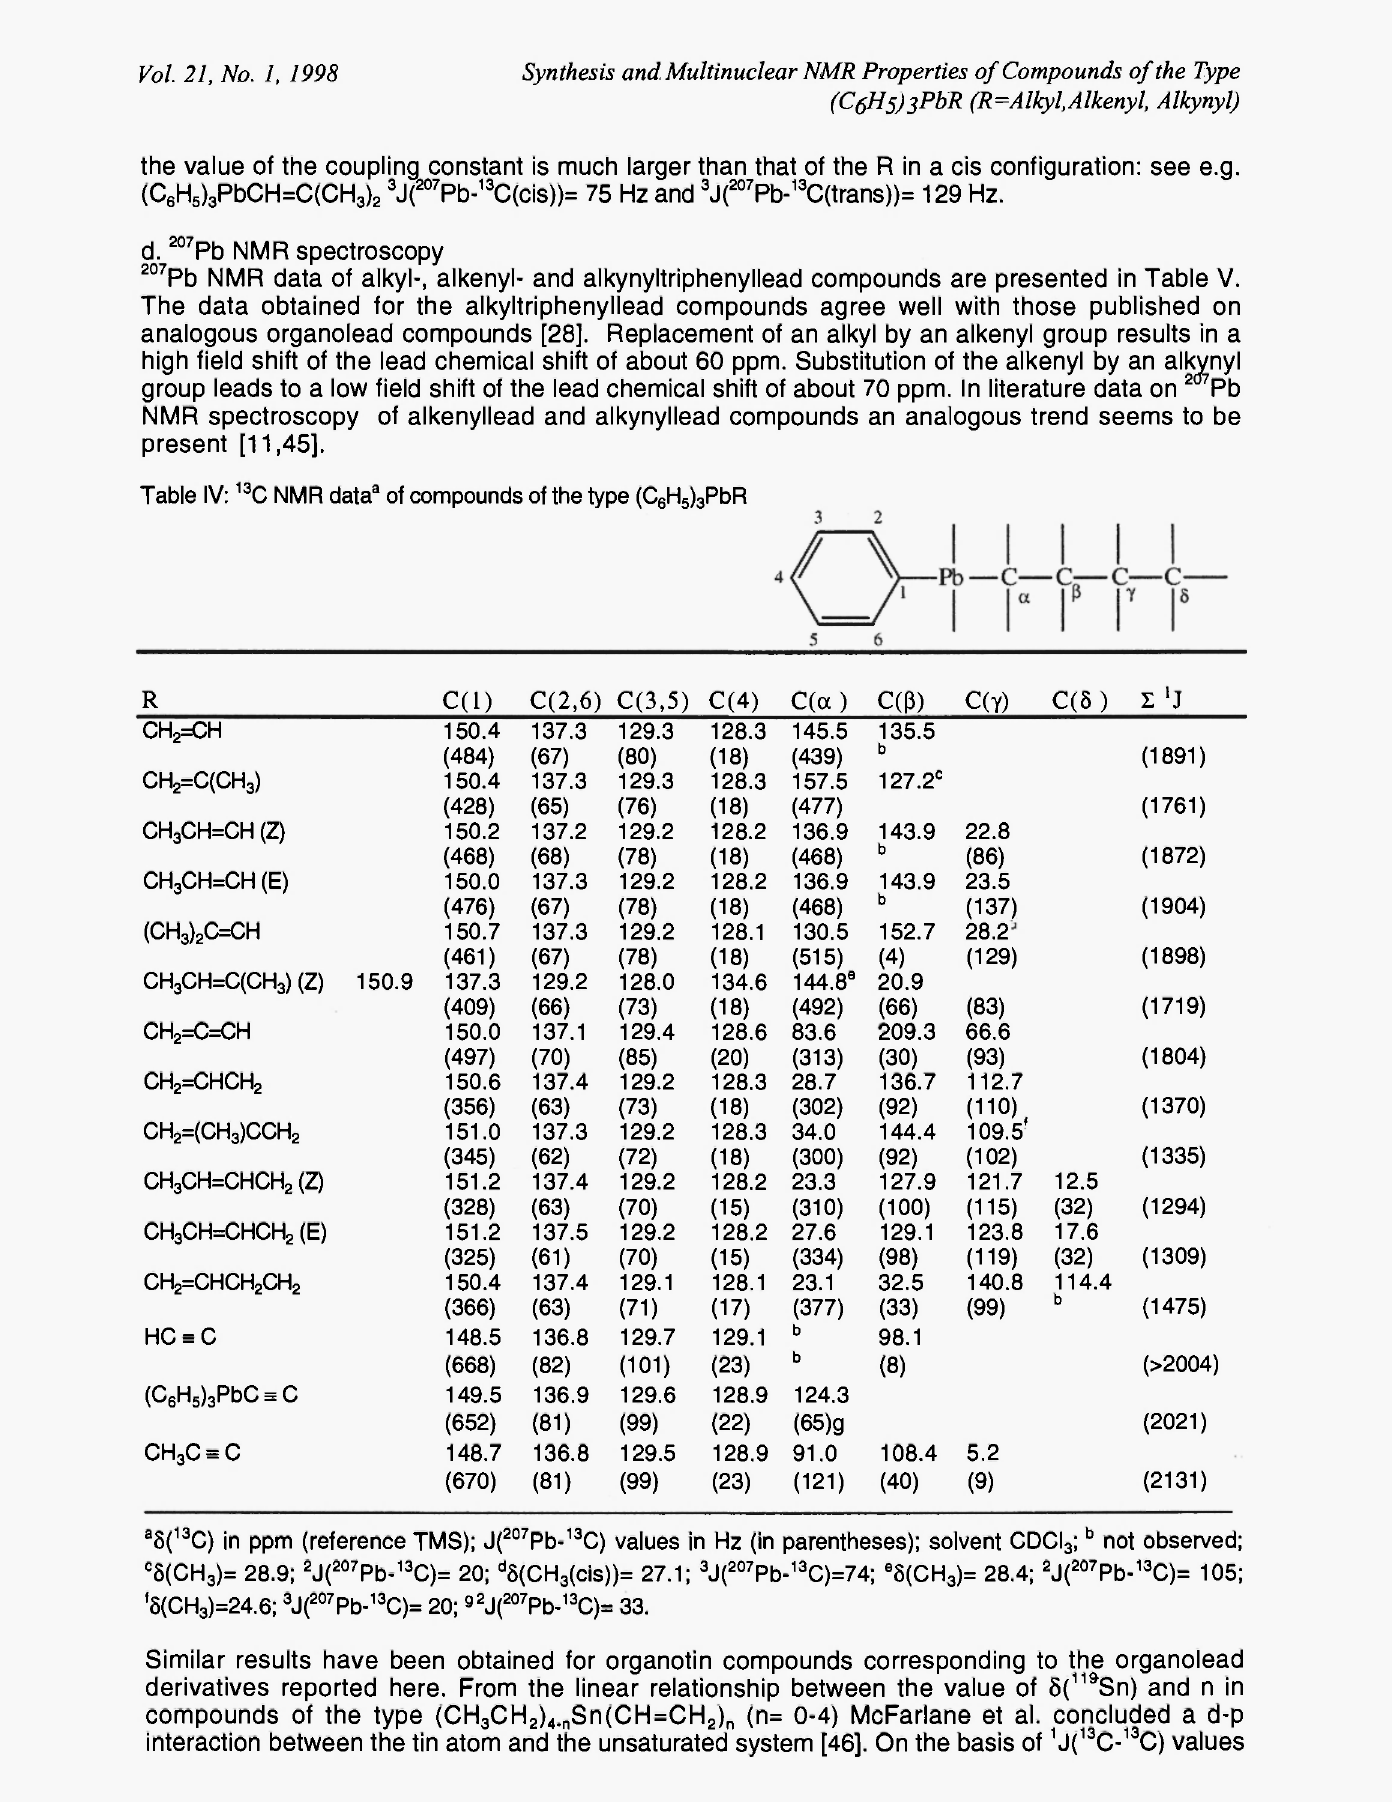
Table IV: 13 C NMR data 3 of compounds of the type (C 6 H 5 ) 3